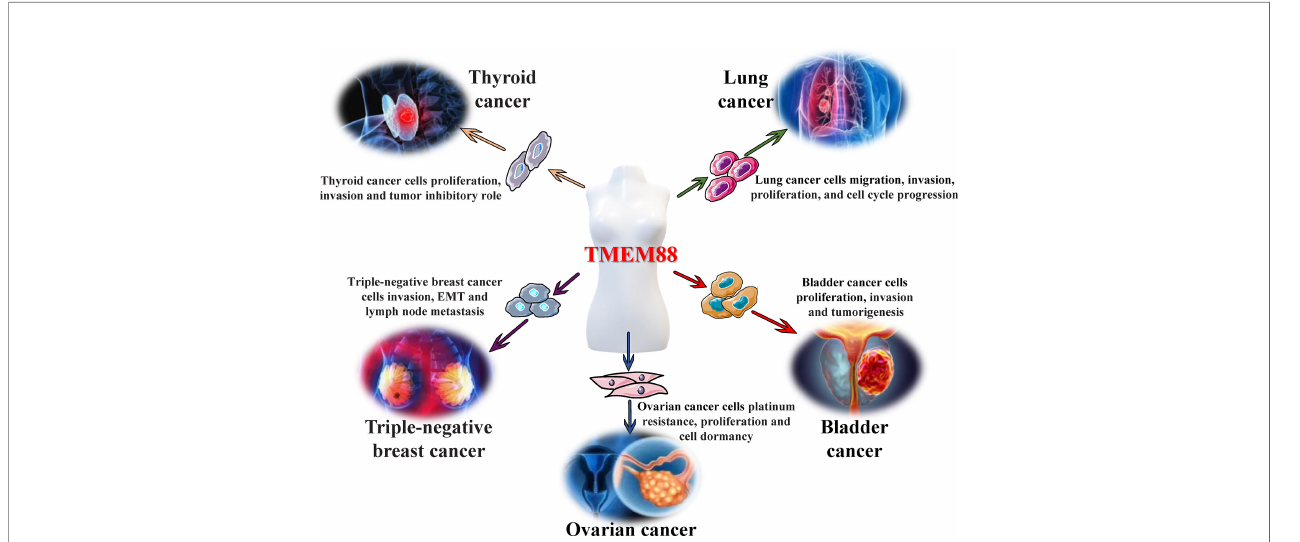
FIGURE 2 | Regulatory effects of TMEM88 in malignant tumors. Different tumor microenvironments, such as in fl ammation and oxidative stress, can cause signi fi cant changes in the levels of TMEM88 in tissues and cells, which will affect tumor cell properties, including abnormal cell proliferation, invasion, migration, and epithelial- mesenchymal transition (EMT), through canonical and noncanonical Wnt/ b -catenin signaling and other signal transduction pathways. These tumor cell properties lead to the occurrence, growth, invasion, and metastasis of various tumors, including ovarian cancer, thyroid cancer, triple-negative breast cancer, bladder cancer, and lung cancer, and ultimately affect tumor progression and poor